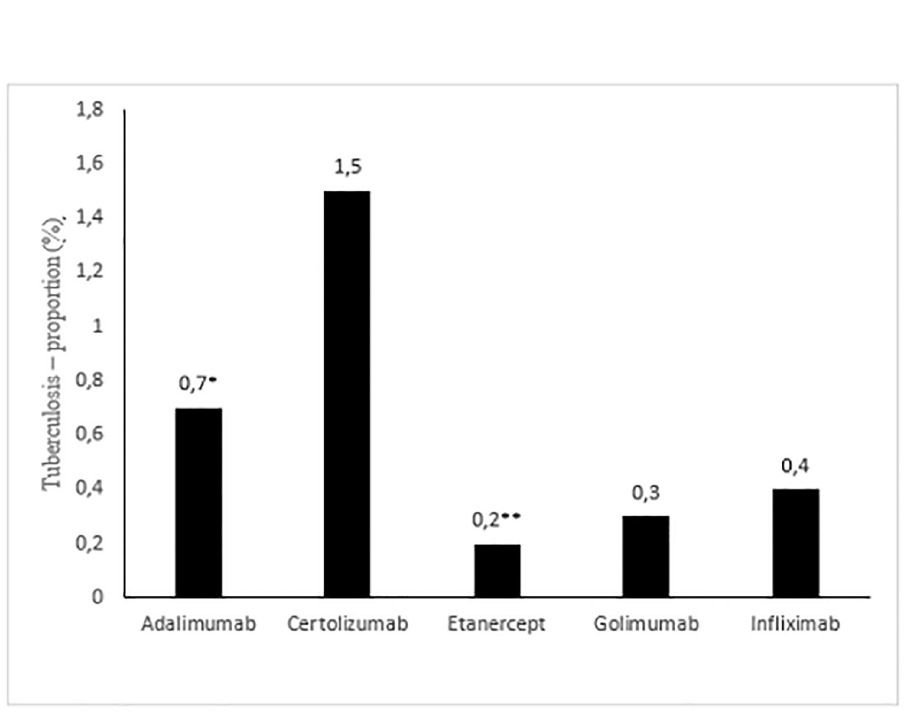
Fig 2. Tuberculosis—Proportion related to first exposure to TNF inhibitors in percentage. � Positive association with tuberculosis. �� Negative association with tuberculosis. p = 0.043, Fisher’s exact test.